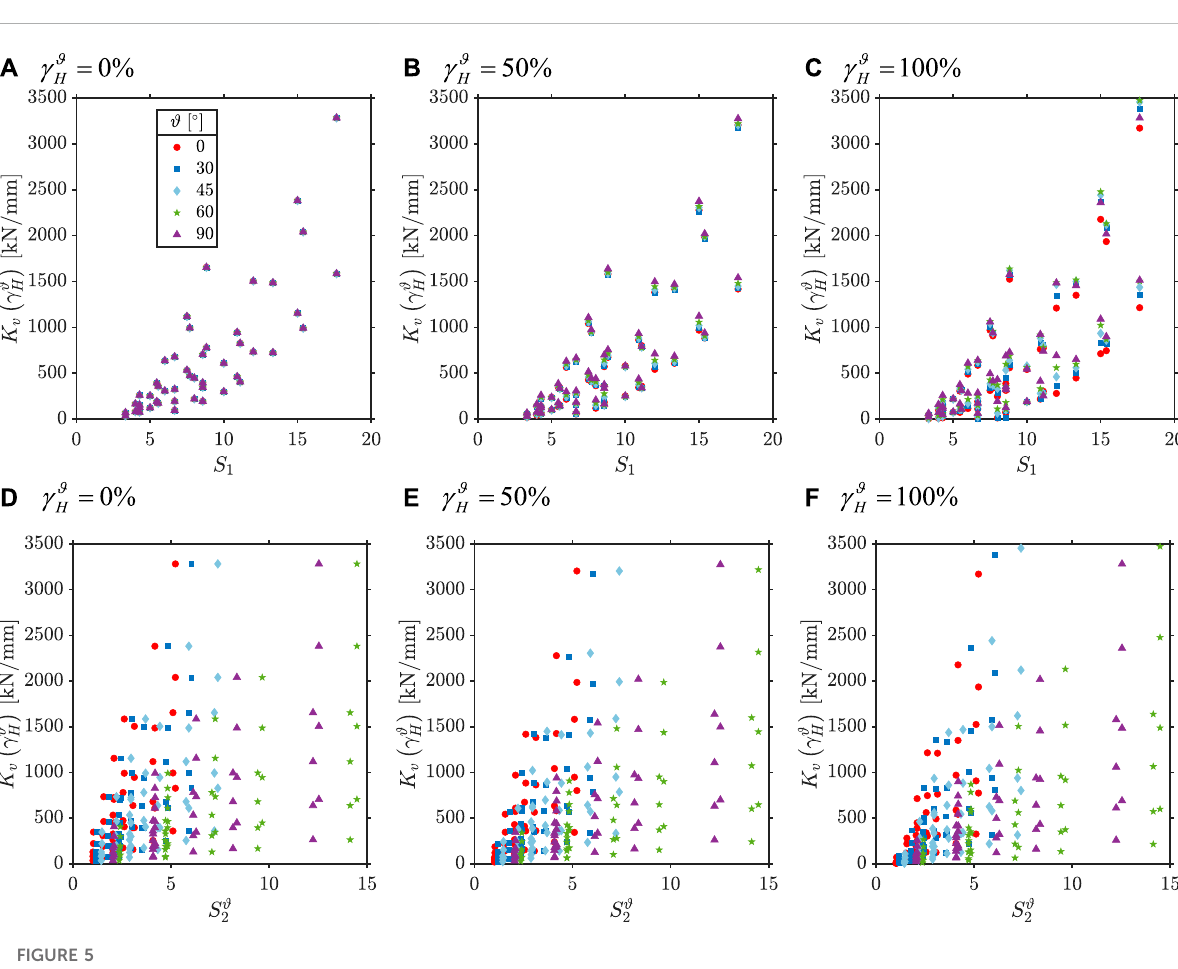
FIGURE 5 Trends of the vertical stiffness with the primary and secondary shape